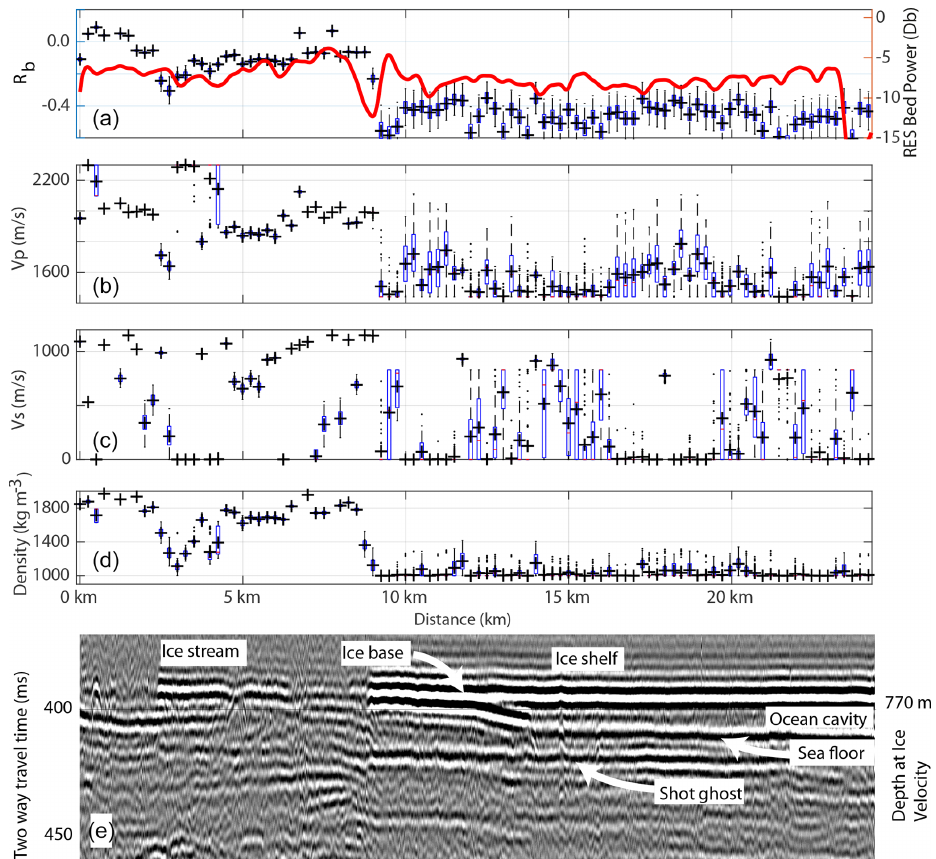
Figure 6. Line 1 (a) seismic basal reflectivity at normal incidence estimated from the average value within 10 ◦ ( R b ). The red line shows radar basal reflectivity from Christianson et al. (2016). (b–d) Box plots of V p , V s , and ρ estimated using Zoeppritz fitting and all estimated source sizes. Blue boxes show the 25th and 75th percentiles, whiskers extend to cover data points, and outliers are plotted as black points. Solutions using the mean source size are overlain as black crosses. All estimates use source sizes obtained using the known reflector method. (e) Stacked active-source seismic reflection profile with ice flow from left (grounded ice stream) to right (floating ice shelf). Shot ghost denotes the short-path multiple generated by the ray path from the source up to the ice–air interface then down. For profile location see Fig. 1.